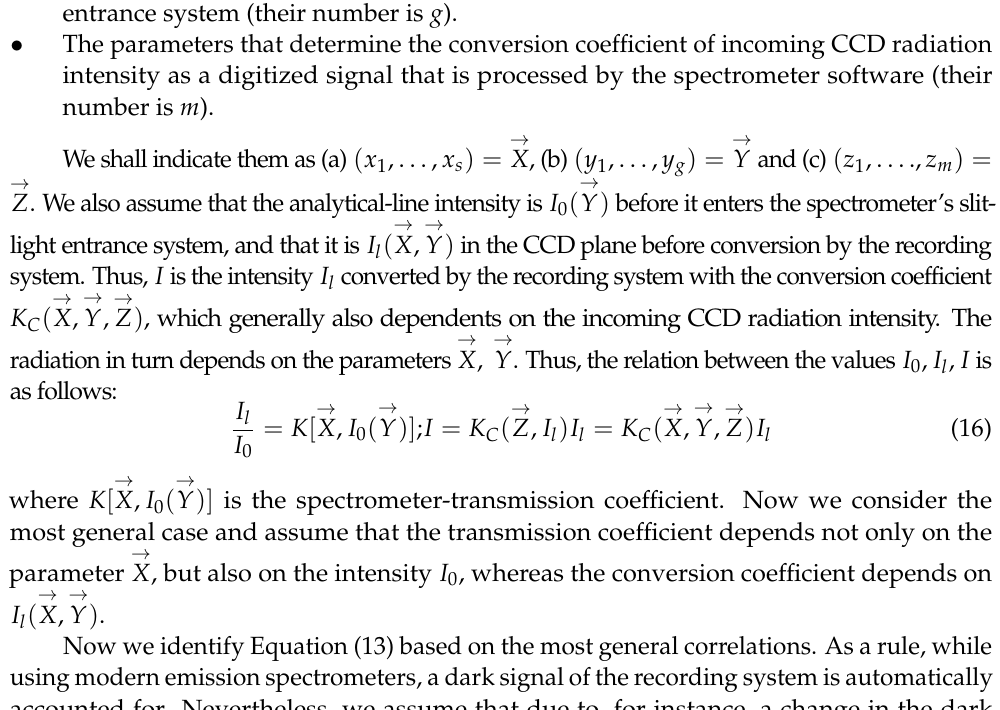
Figure 2. Spectrometer units, of which the characteristics are determined by the parameters (cid:1850)(cid:1318), (cid:1851)(cid:4652)(cid:1318),(cid:1852)(cid:1318) ; ( a ) spectrum-excitation source and sample-atomization system (1), radiation source (2); ( b ) sample-substance-radiation-spectrum-capturing system, including the spectrometer slit-light entrance system (3), entrance slit (4), spectrum-capturing and focusing system on the focal surface (5); ( c ) recording system including CCD radiation receiver and CCD signal converter (6).